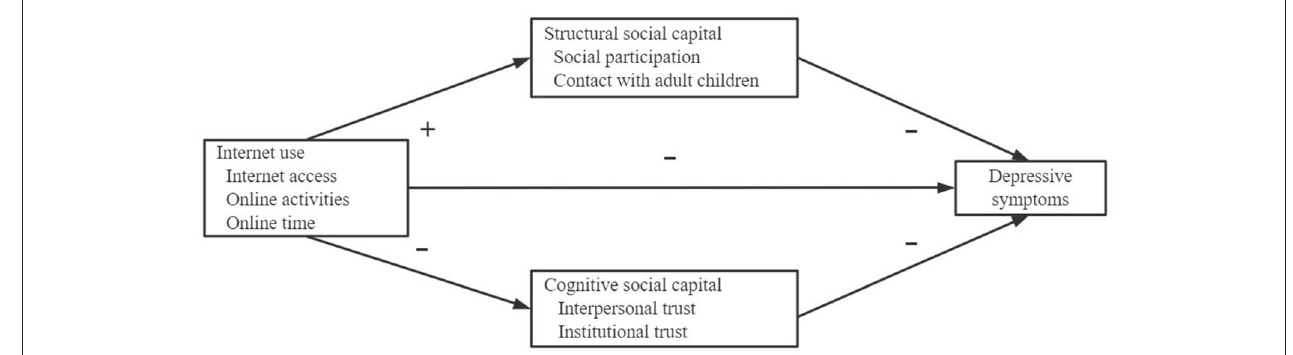
FIGURE 1 | The theoretical